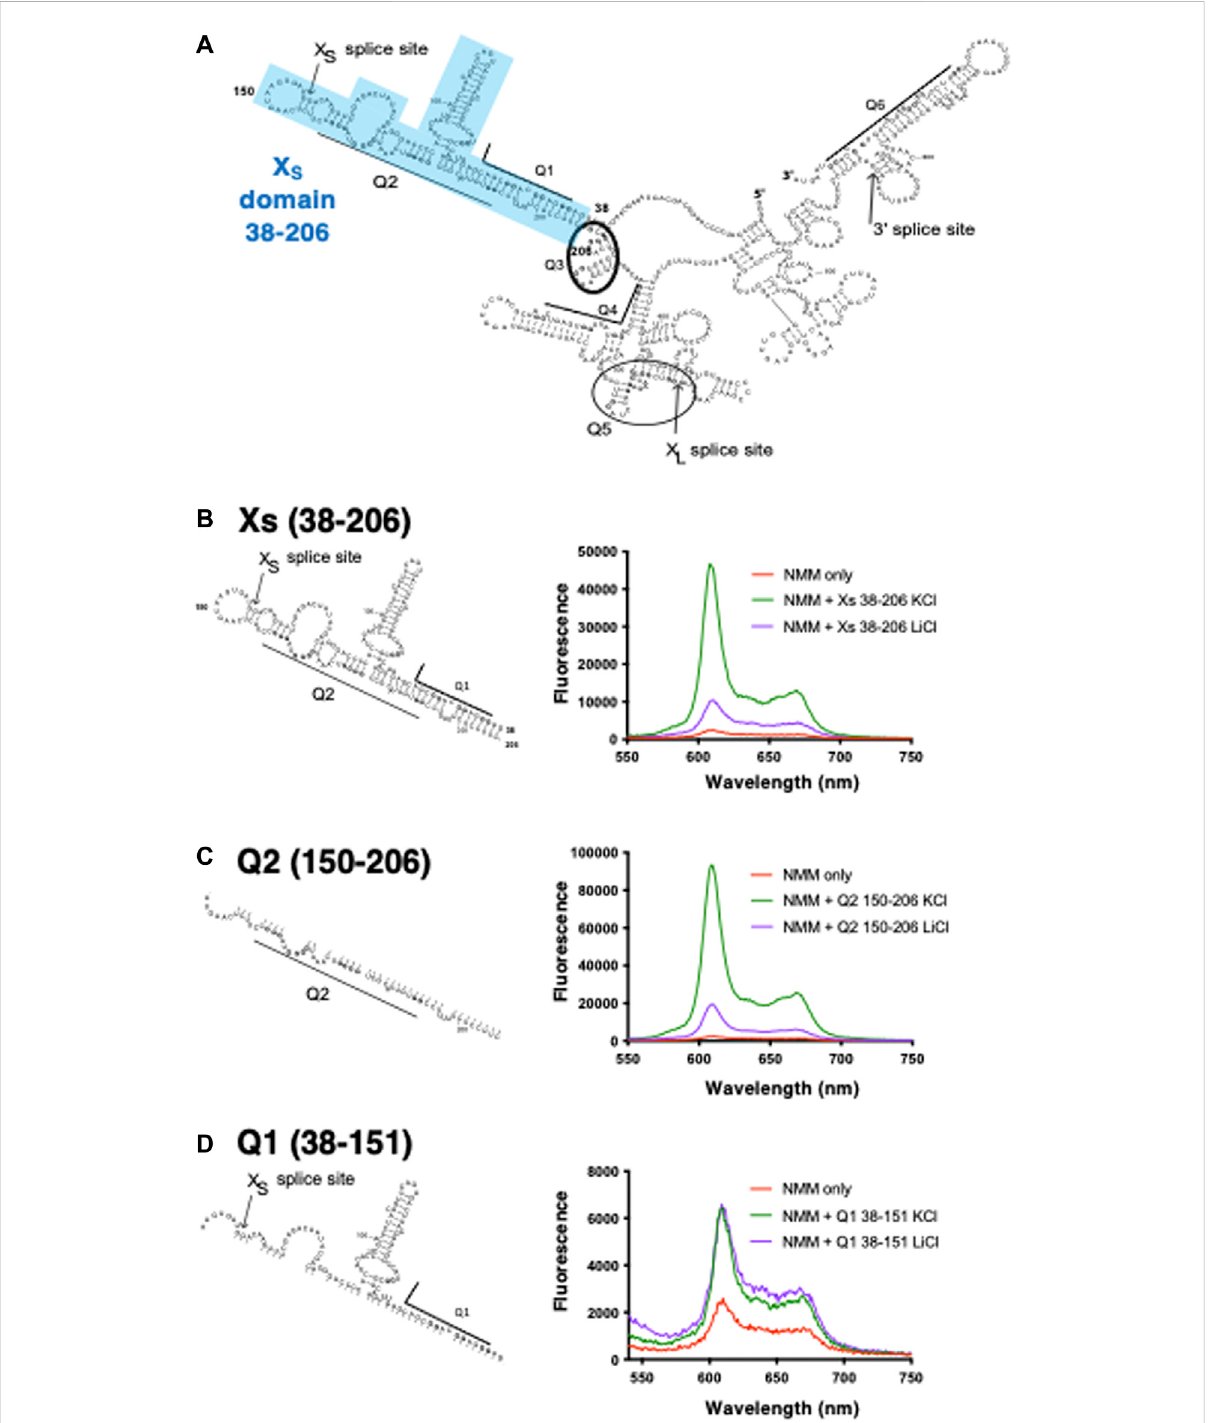
FIGURE 1 SchematicofRNAsusedinthisstudyandNMM fl uorescenceenhancementsinpresenceoftheX S domainanditsconstituentfragments (A) Bcl- x 681 structure previously generated using foot-printing data (adapted from Weldon et al., 2017). Highlighted in blue is the X S domain which covers positions38 – 206containingtheQ1andQ2PQSandharbourstheX S 5 ’ ss.UnderlinedorcircledarethesixPQSsegmentsembeddedwithintheRNA structure (B – D) NMMemissionspectrainthepresenceofX S 38 – 206 (B) ,Q2150 – 206 (C) ,andQ138 – 151 (D) intheabsence(red)orinpresence of 10 µM RNA and 100 mM KCl (green) or LiCl (purple). Experiments were conducted in 10 mM Tris pH 7.0. For clarity, as we are comparing the relative changes in the fl uorescence intensity between KCl and LiCl, the Y axis scaling is different in each